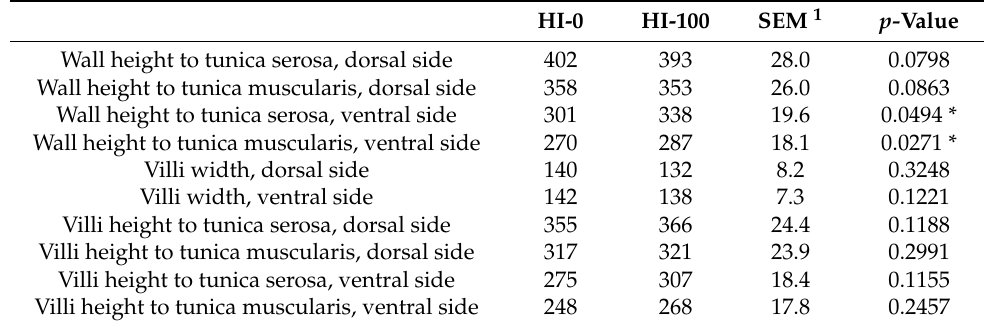
Table 4. Intestinal morphometry of the HI-0 and HI-100 groups.